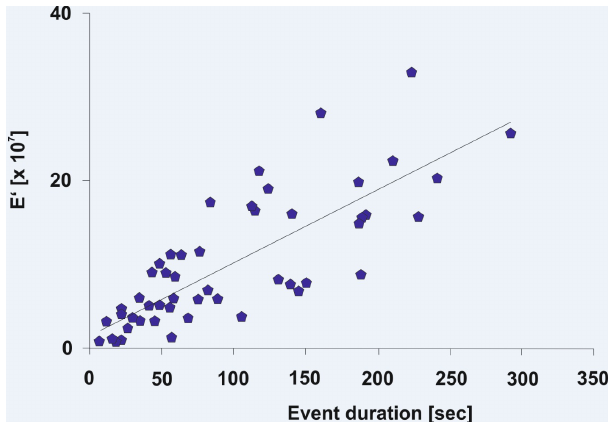
Fig. 12. Pseudo-energy E 0 vs. duration of rockfalls in seconds; R 2 is